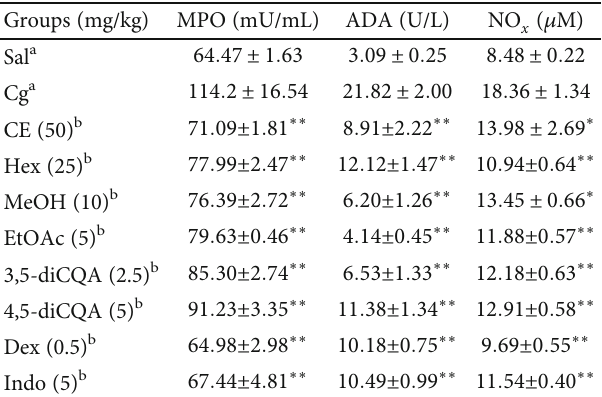
Table 2: E ff ects of CE, fractions, and isolated compounds obtained from C . pinnati fi da leaves upon myeloperoxidase (MPO) and adenosine deaminase (ADA) activities and nitrate/nitrite (NO x ) levels in a murine model of carrageenan-induced